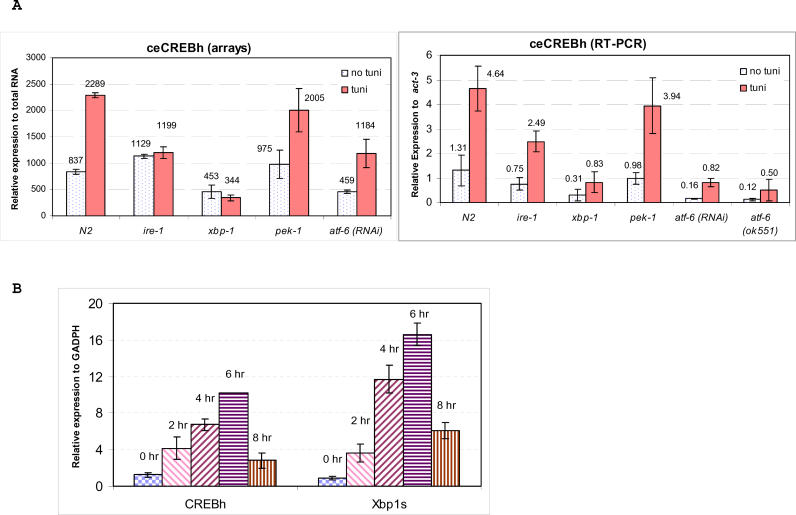
CREBh Is a Novel UPR-Responsive Gene(A) Microarray and quantitative RT-PCR analyses show that the expression of C. elegans (ce) CREBh requires ire-1, xbp-1, and atf-6. “Tuni” indicates tunicamycin treatment, as described in the Materials and Methods section.(B) ER stress induced by dithiothreitol in HepG2 cells activates CREBh transcription. HepG2 cells were treated with dithiothreitol and harvested at various time points from 0 h to 8 h. The relative expression of CREBh and spliced xbp-1 transcripts (Xbp1s) was analyzed by quantitative RT-PCR and normalized to GADPH. The induction pattern of CREBh resembles that of spliced xbp-1 transcripts.